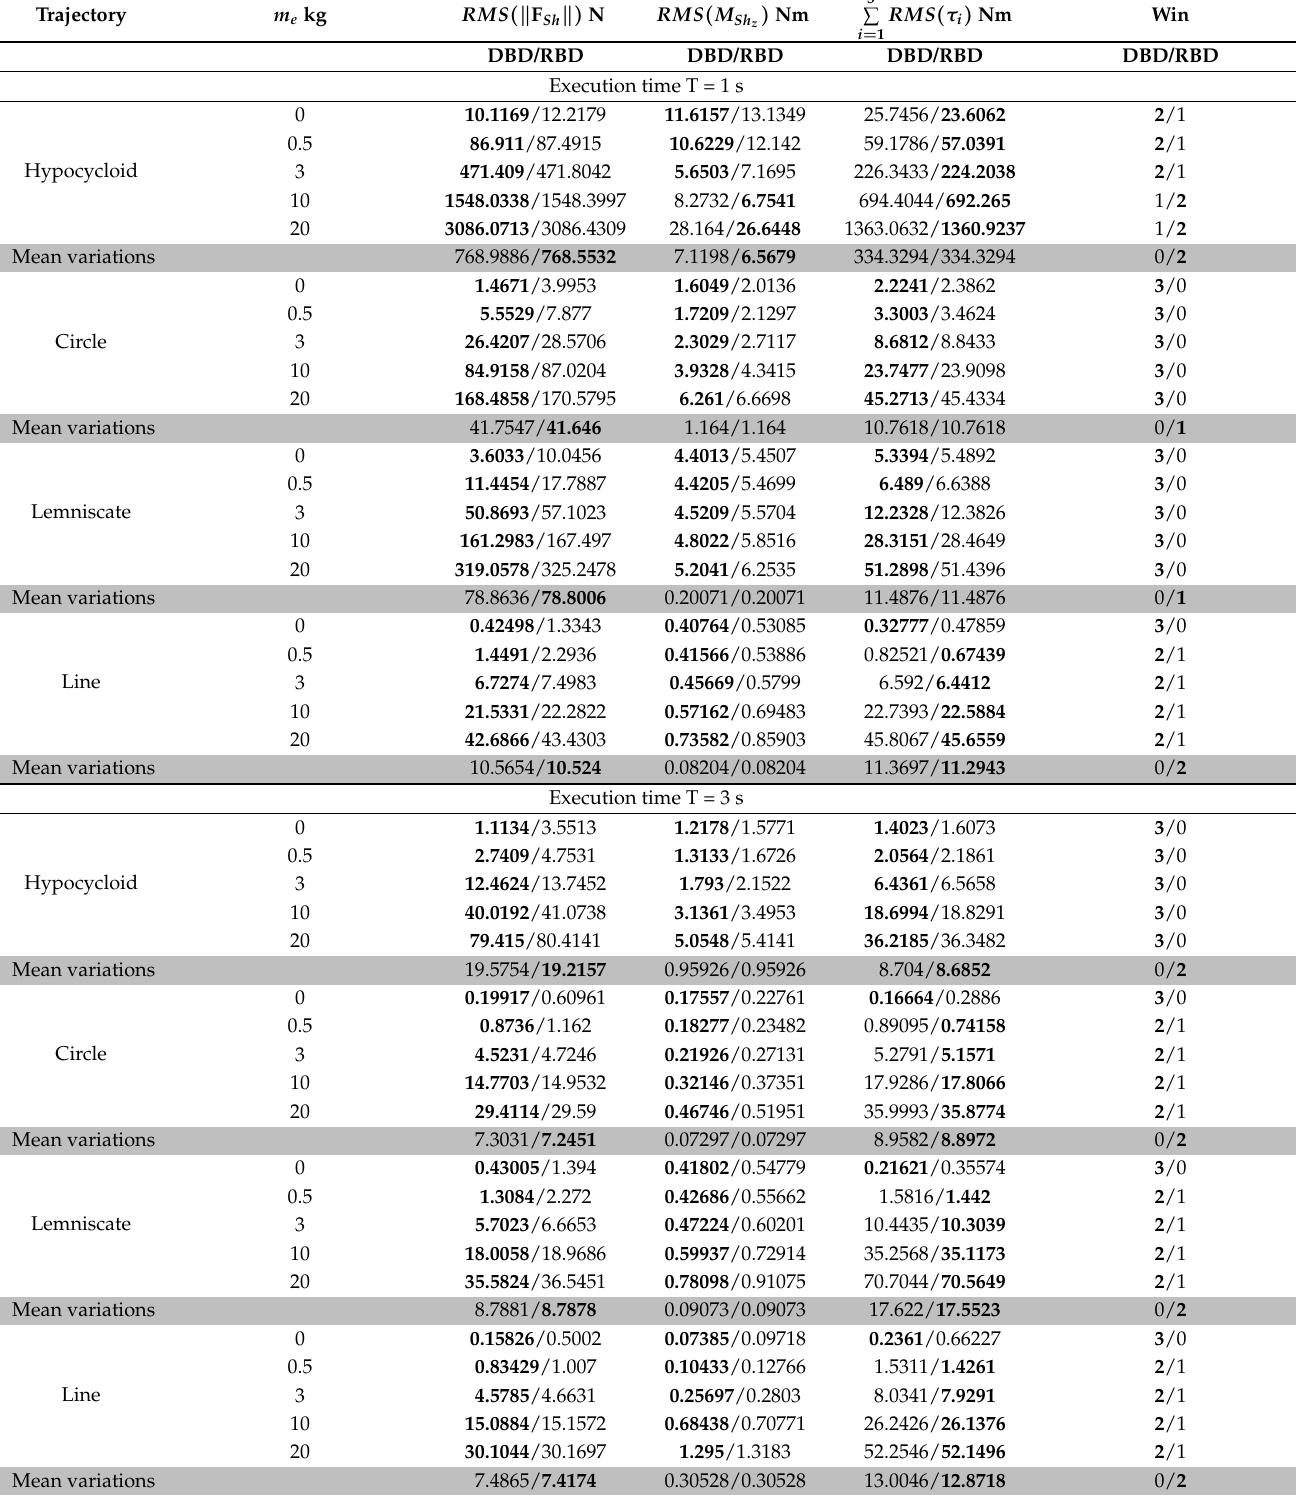
Table 8. Comparative results of the RBD with respect to the DBD with different tasks, speeds, and end-effector